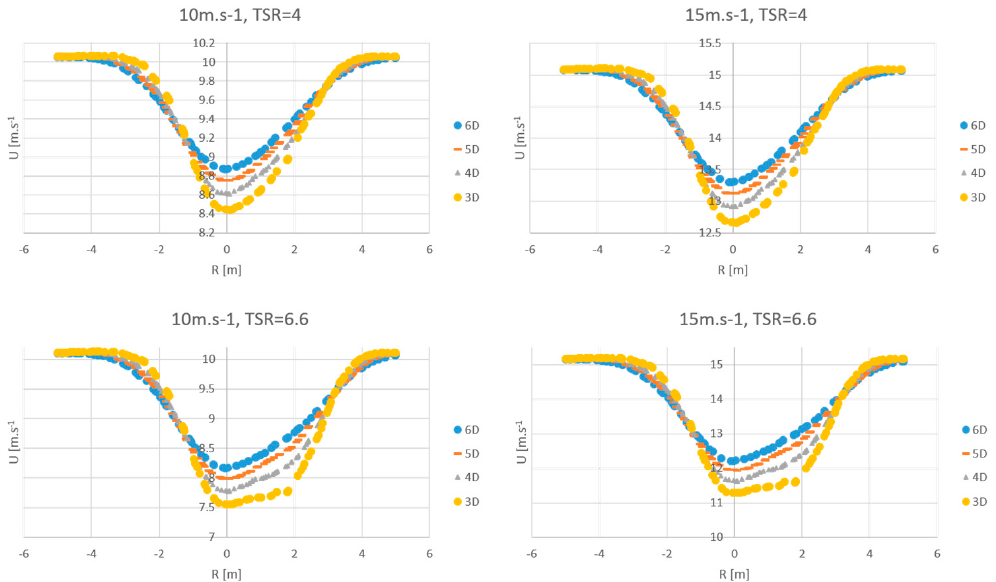
Figure 7. Velocity deficit for two different values of Tip Speed Ratio (TSR) and free-stream velocity.